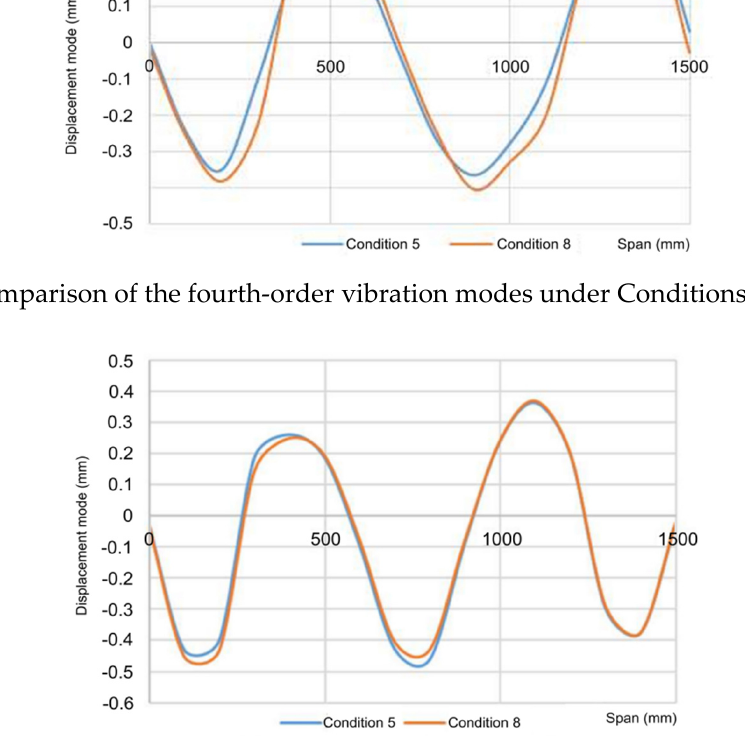
Figure 14. Comparison of the first five orders of vibration modes under Conditions 5 and 8.